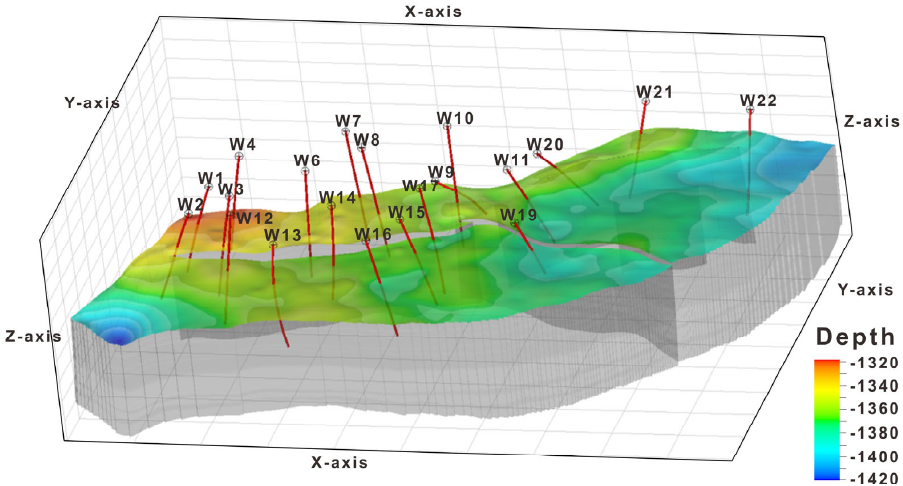
Figure 11. 3D grid of the reservoir